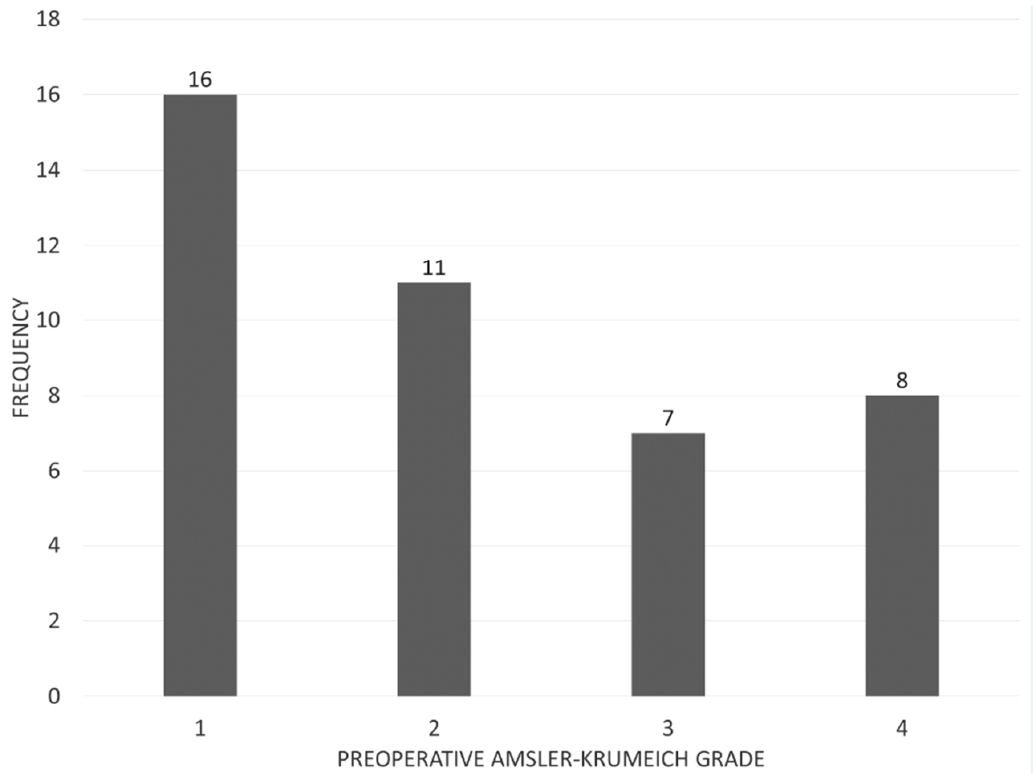
Figure 2. Distribution of preoperative Amsler–Krumeich staging.